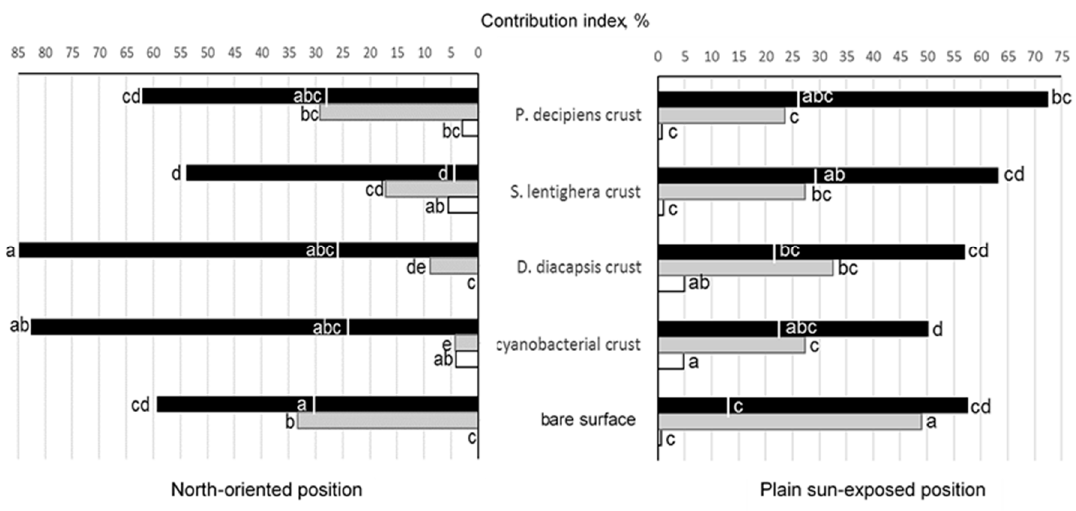
Figure 7. Contribution of main microfungal groupings to communities’ structure in different crust types and bare surface at the Tabernas Desert: —melanin-containing microfungi; — Aspergillus spp.; — Penicillium spp.; the area left (plain sun-exposed position) or right (north- oriented position) from the line on the bars of melanin-containing microfungi indicates contributions of species with large multicellular spores. Means with the same letters are not significantly different (a one-way ANOVA, the Fisher test, at the 5% level).